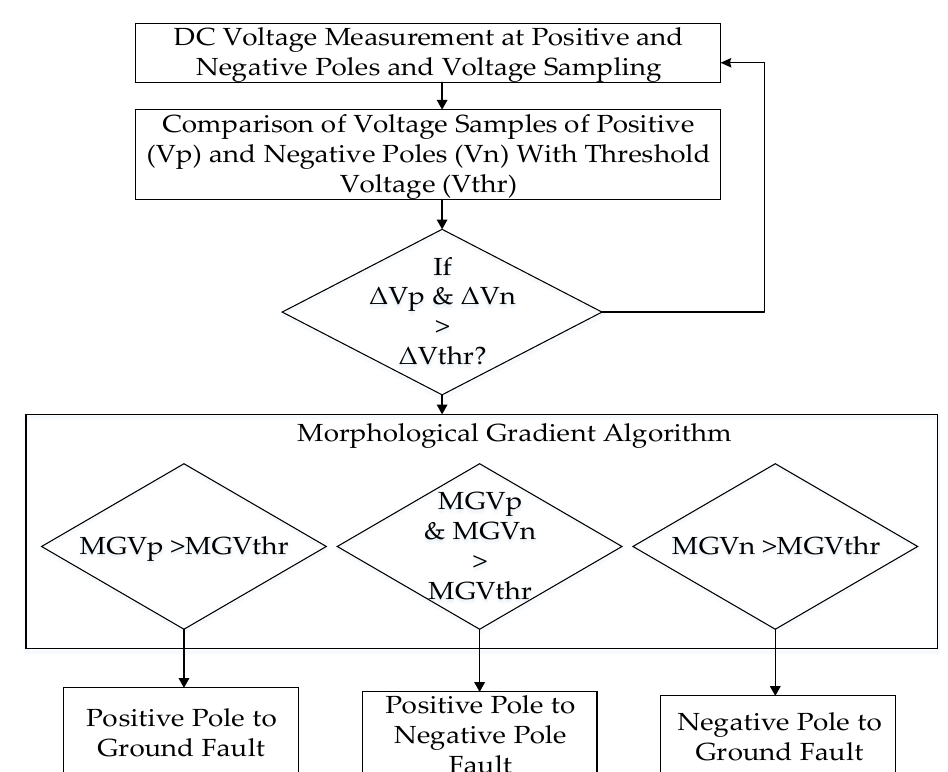
Figure 18. Proposed flow chart of Morphological gradient algorithm for fault classification in multi-terminal high-voltage direct current (MT–HVdc) transmission system.